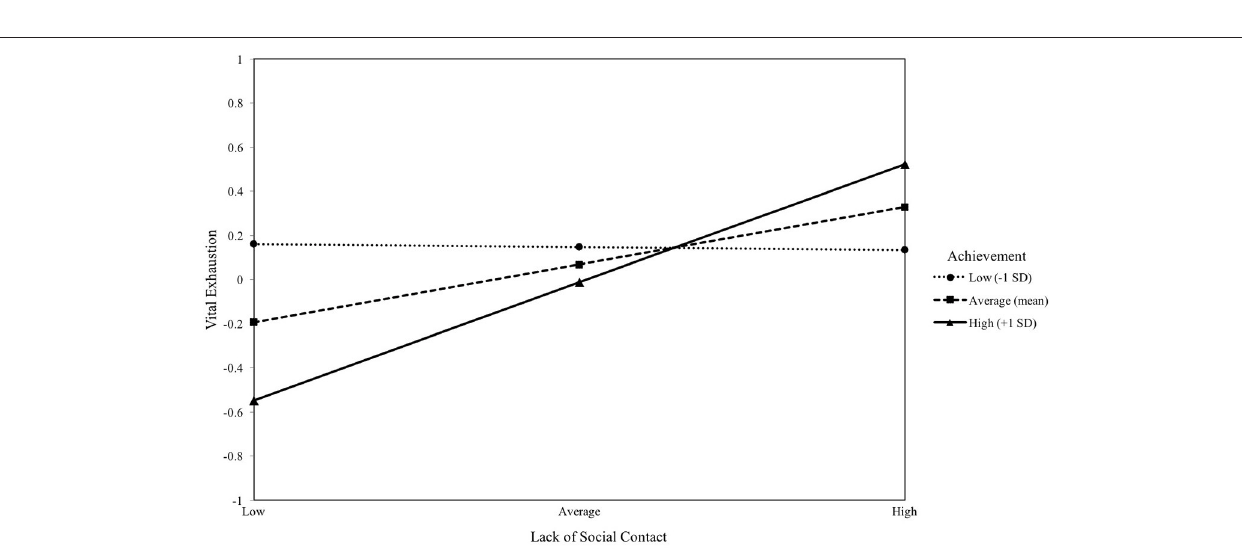
FIGURE 4 | The moderating effect of implicit achievement motive on the association between work discontent and vital exhaustion. Simple slopes of work discontent predicting vital exhaustion for 1 SD below the mean of achievement, at the mean of achievement, and 1 SD above the mean of achievement.